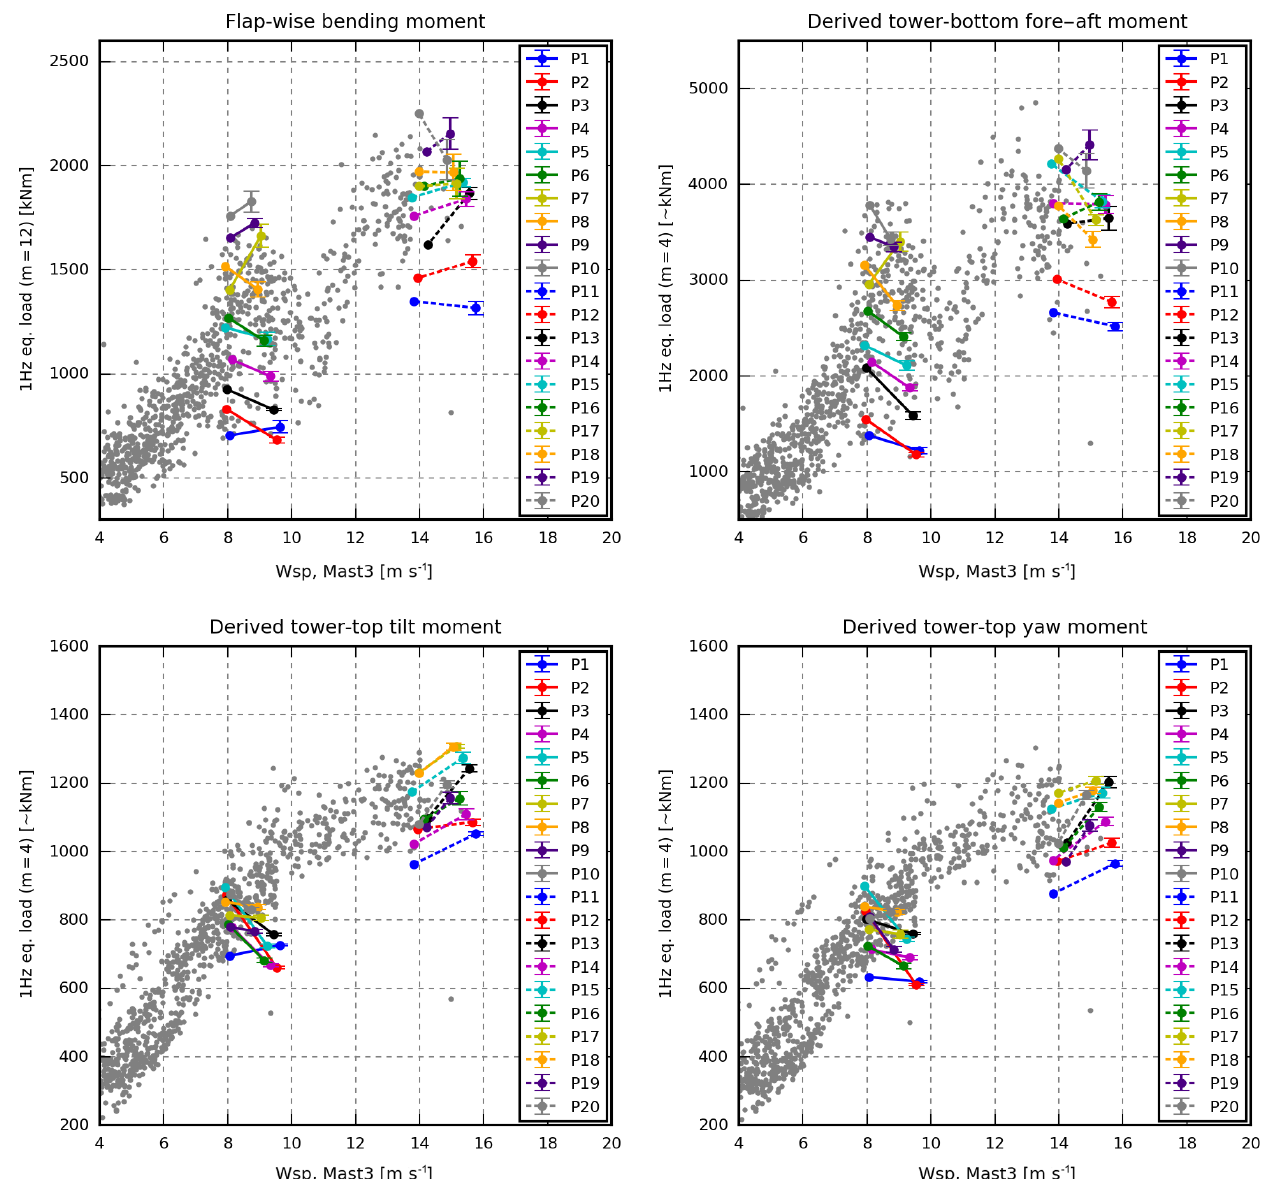
Figure 17. Case 5. Best case based on pitot-tube inflow information. For interpretation see Fig.